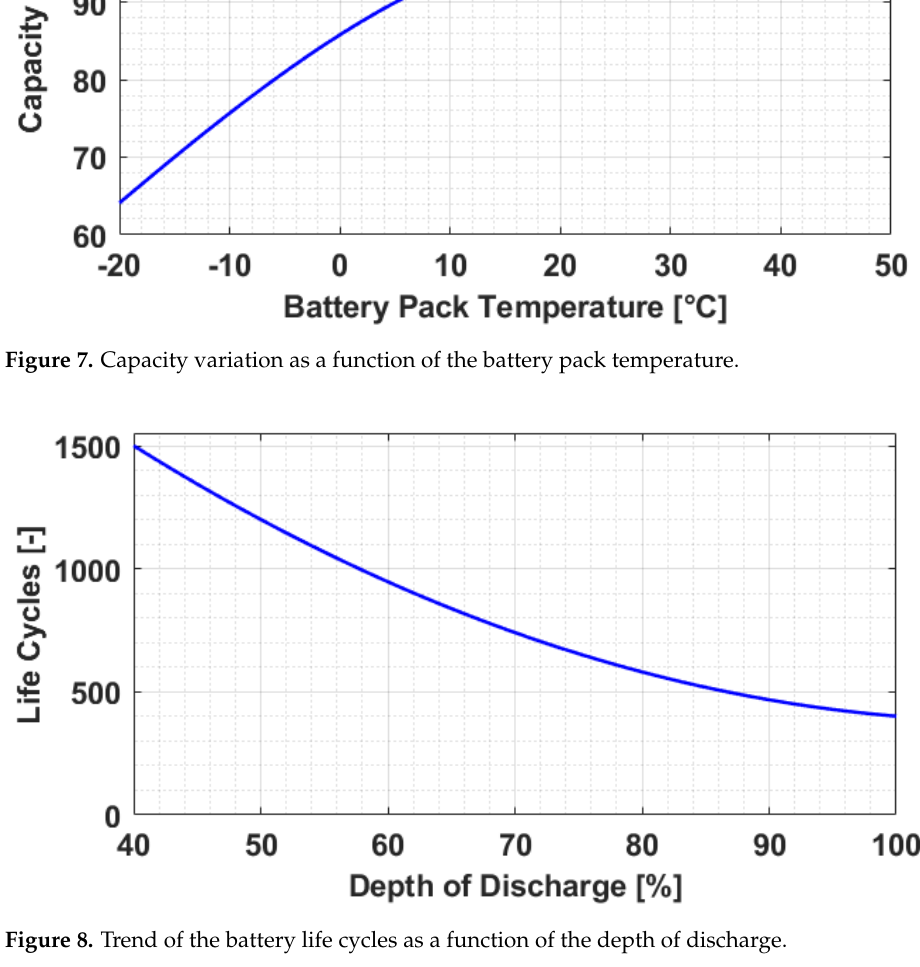
Figure 9. Capacity fading in terms of battery depth of discharge equal to 80% (DoD80) and 100% (DoD100). Using the same approach as for 𝜆 𝑡 𝑏𝑝 , the values of 𝜆 𝑆𝑜𝐻 were considered in the range (0.8, 1). Once the available capacity of the battery was determined, a correct evaluation of the battery SoC was performed by producing a good estimation of the current flowing into the battery (see Equation (20)). To achieve this, the power required by the road (i.e., the